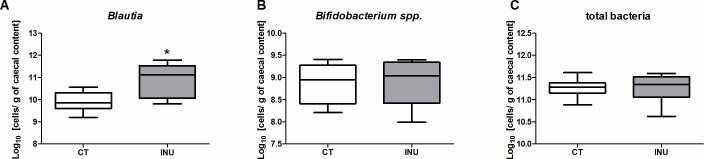
qPCR analysis of the caecal luminal microbiota.Levels of Blautia (A), Bifidobacterium spp. (B) and total bacteria (C) in the caecal content of mice fed a control diet (CT) or a diet supplemented with 5% inulin (INU) for 27 days. *p<0.05 (Student t test).